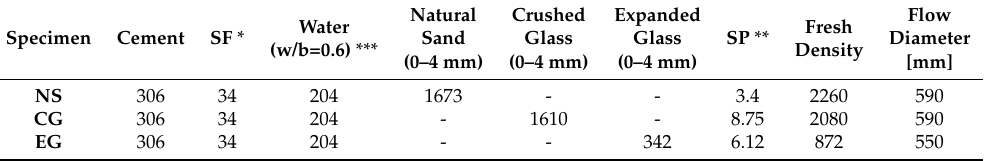
Figure 4. µ -CT imaging process to investigate pore and solid characteristics: (a) original µ -CT image, (b) contrasted image, (c) binarized image for aggregates, (d) binarized image for pores, (e) 3D µ -CT image (Note: in (c) and (d), the white regions represent aggregates (c) and pores (d) while the black is a background.) pore, aggregate, and solid phases. In general, the solid phase (binder) of concrete is composed of 192 several components, i.e., calcium-silicate-hydrate (C-S-H) and calcium hydroxide (CH); however, the 193 main objective of this study was to clarify the effect of different aggregates on concrete properties 194 as well as their pore characteristics with the binder assumed to be a single phase for simplicity. In 195 this study, we used the same cubic specimens which were used for the measurements of the thermal 196 conductivity, and the core from the middle of each sample is used for µ -CT to obtain high-resolution 197 images. 198 3.2. Thermal conductivity measurements 199